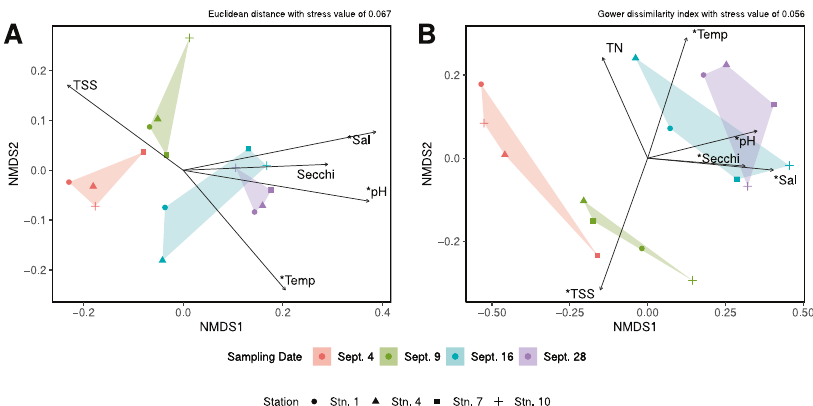
Fig. 3 NMDS showing that samples grouped by collection date rather than geographic location within Galveston Bay. NMDS from the complete gene pool ( A ) and the MAGs ( B ), with stress in both plots of type 1, with 2 dimensions, ( A ) had a stress value of 0.067 and ( B ) of 0.056. Dissimilarity indices were assessed via the rankindex function in vegan the euclidean index was used in ( A ) while the gower index was used in ( B ). Signi fi cant environmental conditions ( α < 0.10) are shown as vectors the lengths of which have been halved in order to better visualize the groupings. Signi fi cant vectors with an α < 0.05 are denoted with